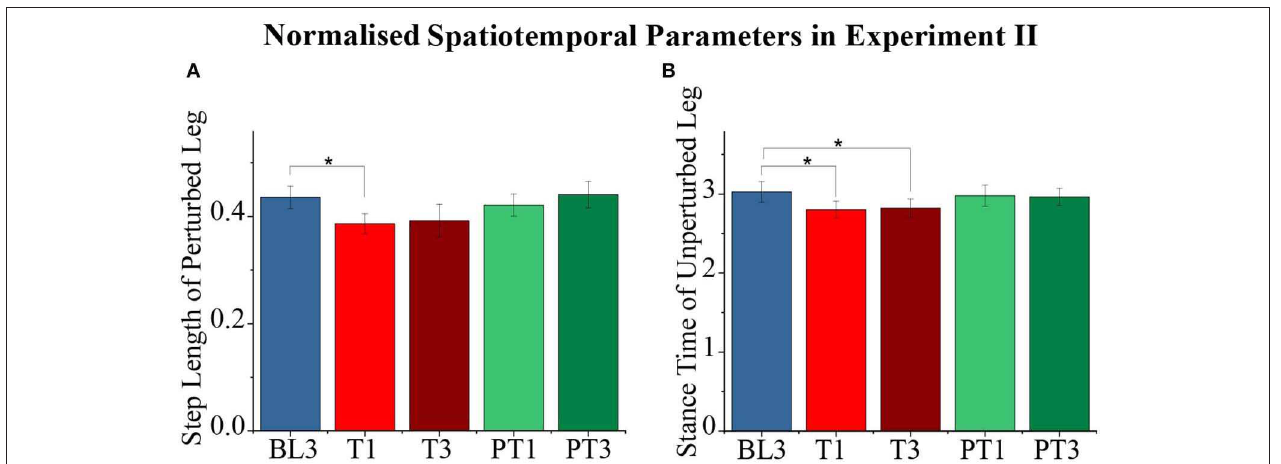
FIGURE 11 | (A,B) Normalized step length, stance time of the perturbed leg for different sessions. The data presented here are averaged across all participants of Experiment II with standard error (* p < 0.05).